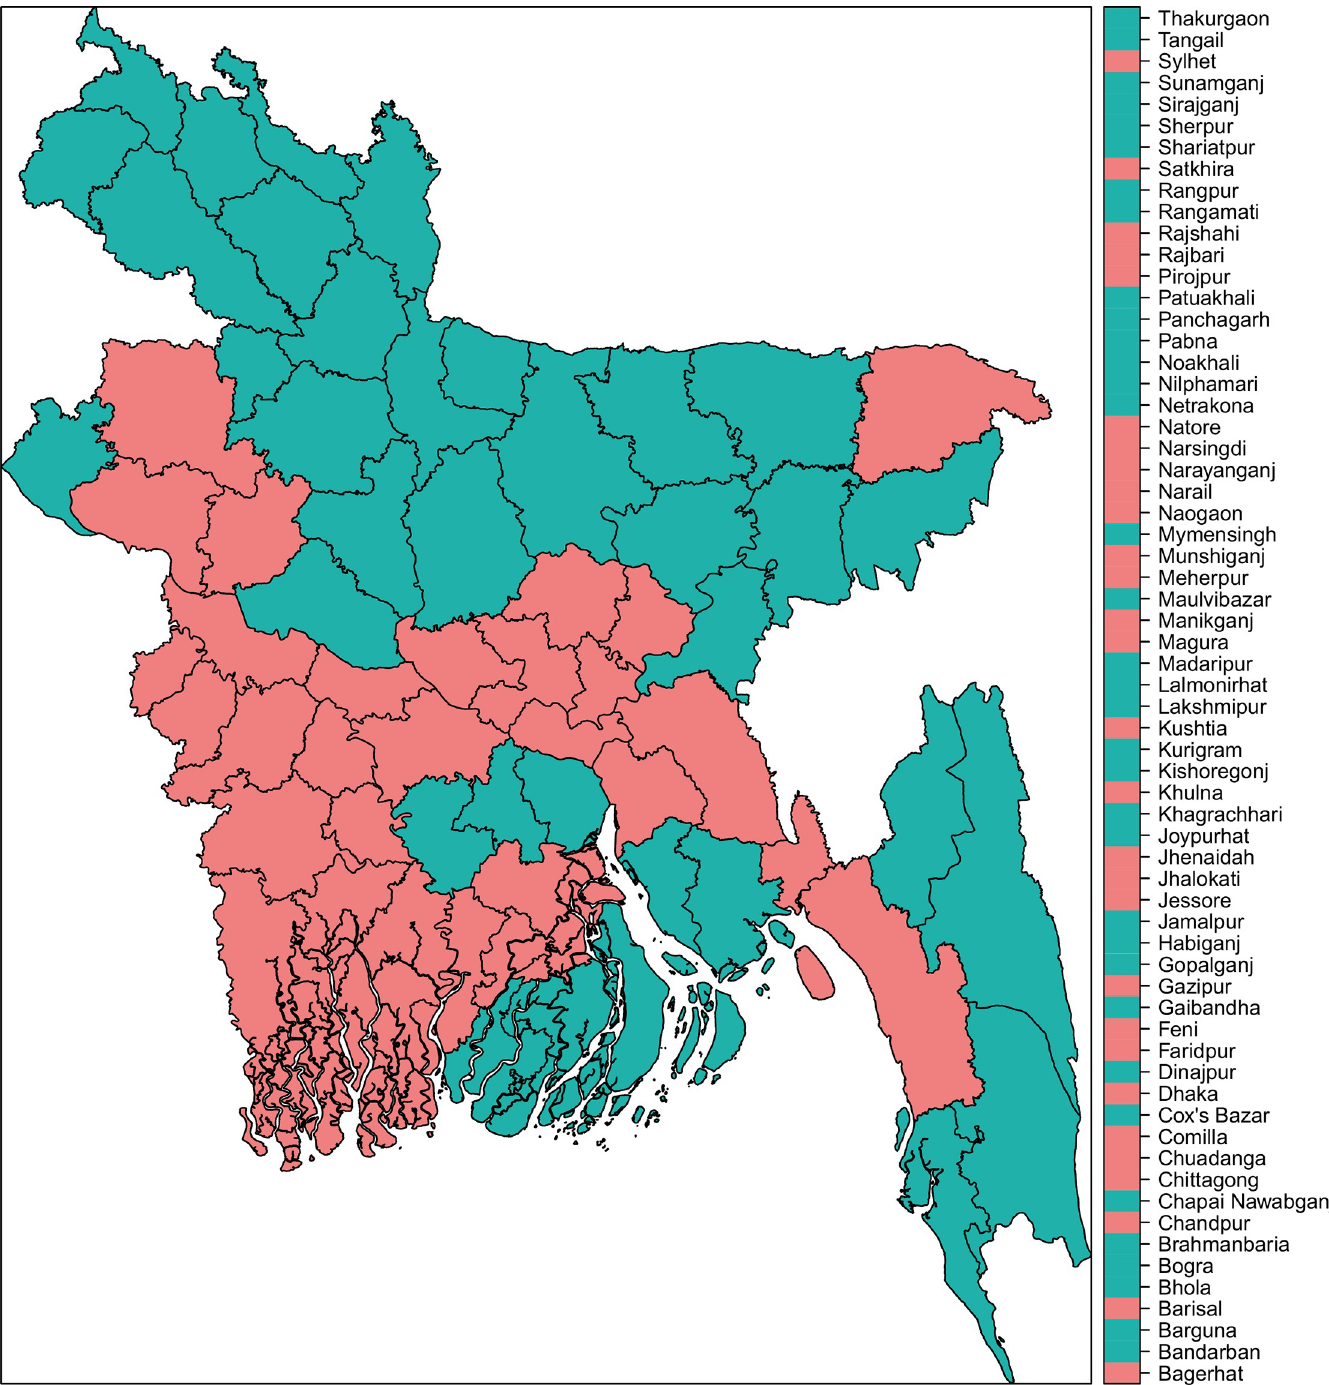
Fig 7. Regional distribution of the clustered districts based on all indicators combined. The map depicted in this figure is our own. Under-performing districts (red) are mostly from the North and Northeastern part while the majority of the well-performing districts are in the central and Southwestern parts of Bangladesh.